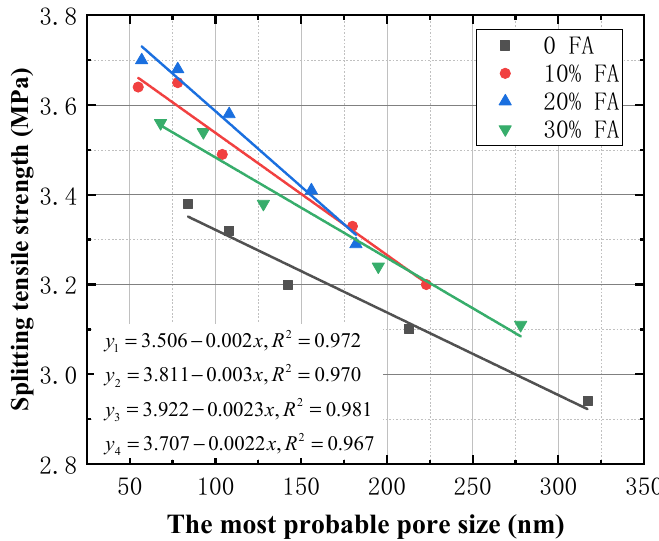
Figure 14. Relationship between splitting tensile strength and the most probable pore size.